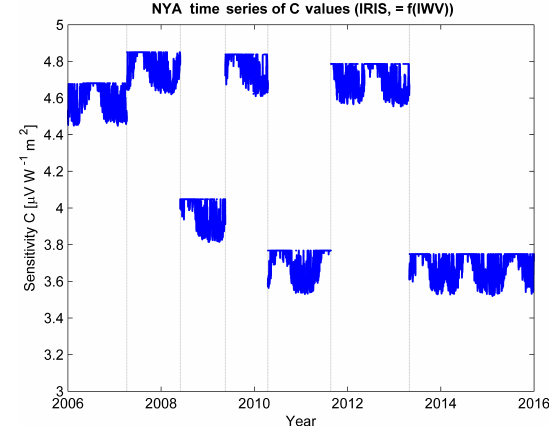
Figure 2. Monthly mean values of downward longwave radiation for all-sky (blue) and clear-sky (red) conditions for the 2006–2015 period at NYA. Corresponding all-sky (light grey lines) and clear- sky (dark grey lines) conditions for 1min values are shown in the background for comparison.